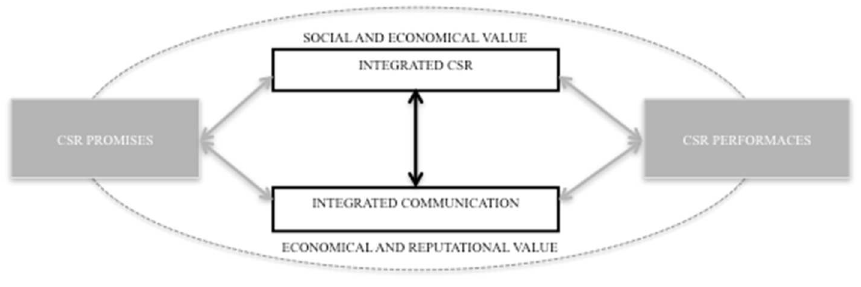
Figure 4: The Integrated CSR Communication Virtuous